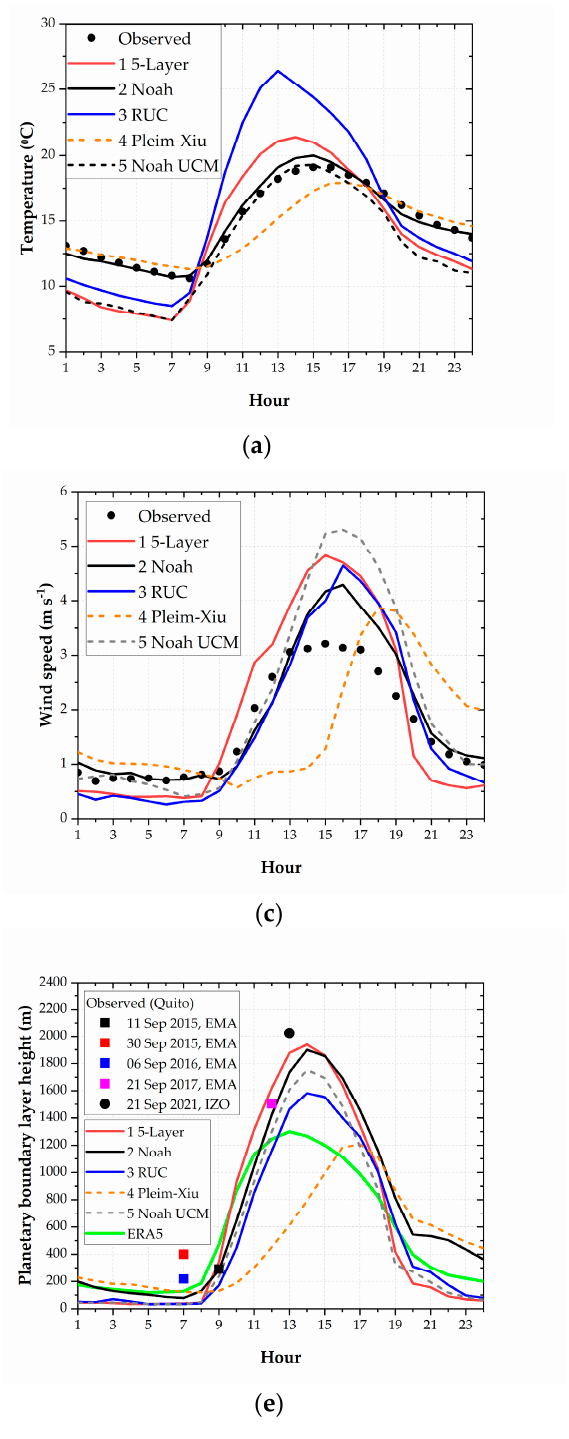
Figure 3. Daily mean profile during September 2014 at the location of the MUN station: ( a ) Temperature. ( b ) Global solar radiation. ( c ) Wind speed. ( d ) Wind direction. ( e ) Planetary boundary layer height (PBLH). Squares in ( e ) show PBLH observations at the EMA station [42]. The black dot indicates the observation at the IZO station [43]. ( f ) The modeled upward heat flux at the surface by the schemes. Table 5. Metrics for the meteorological modeling. Bold numbers indicate values in the benchmark ranges.